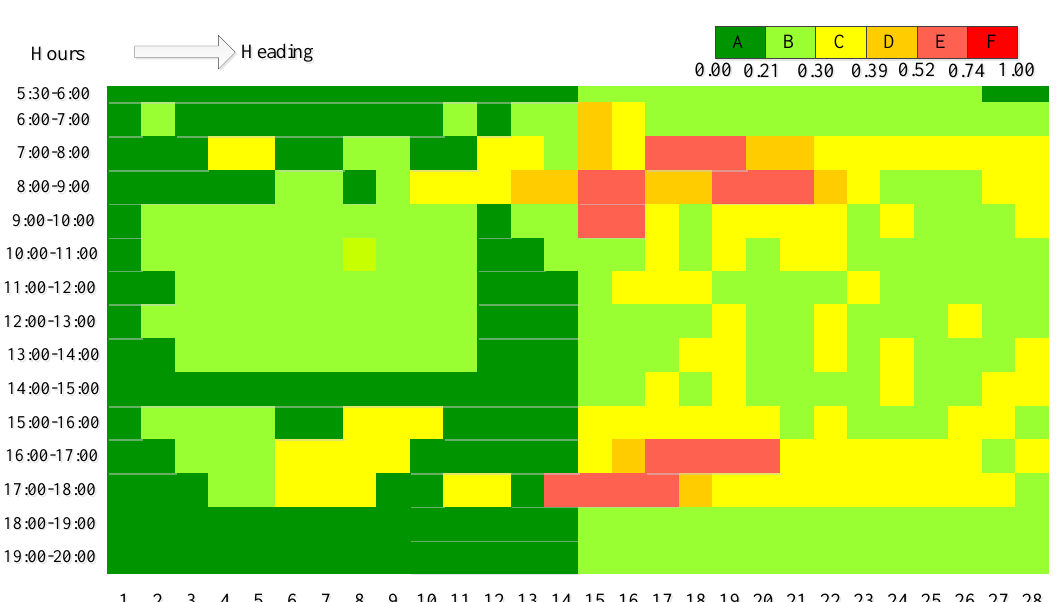
Figure 2. Temporal and spatial distributions of the headway service level of Route